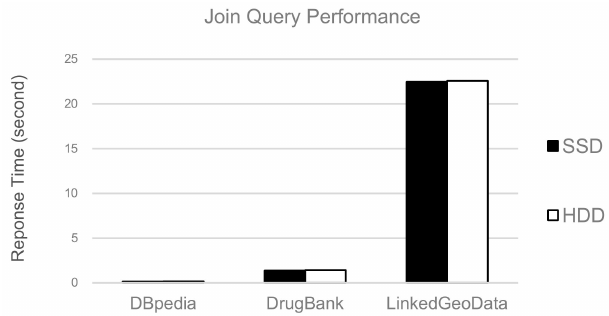
Figure 12. Three-dimensional R*-tree performance on SSD and HDD.